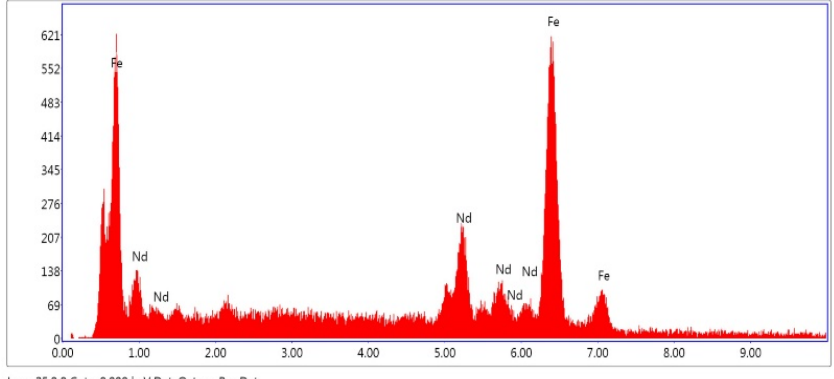
Figure 4. SEM analysis of NdFeB magnet powders.